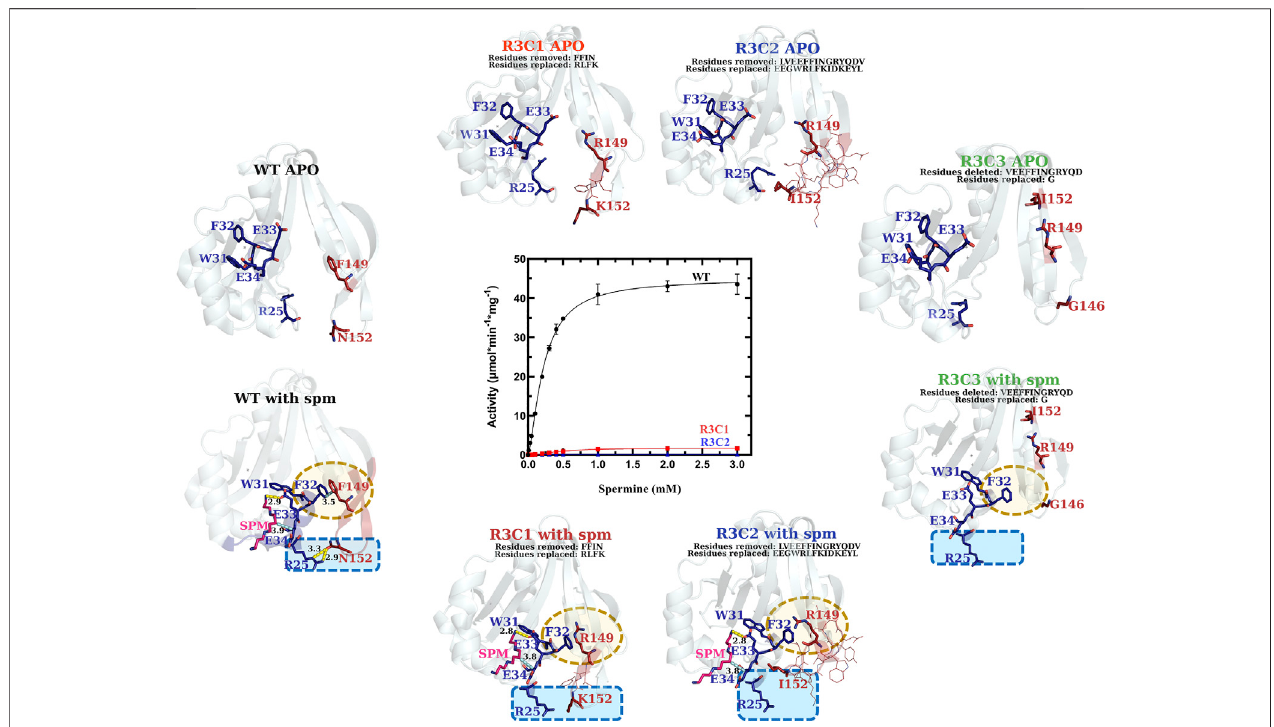
FIGURE 7 | Comparison of kinetic activity and structures/models of Region 3 chimera and deletion constructs (R3C1-R3C3). The apo-crystal structure of R3C1 and homology models of R3C2 and R3C3 are shown along thetop of thesubstrate saturation kinetic plot, whereas homology models ofR3C1-R3C3 constructs based ontheWTspm-boundcrystalstructure (PDB ID:4mi4)arealongthebottom. Regions ofvariabilityarehighlightedinyellowand bluedotted shapes.H-bondsareshown as dashed yellow lines. Speci fi c residues of interest are shown as sticks and labeled and lines of less interest are shown as lines and are not